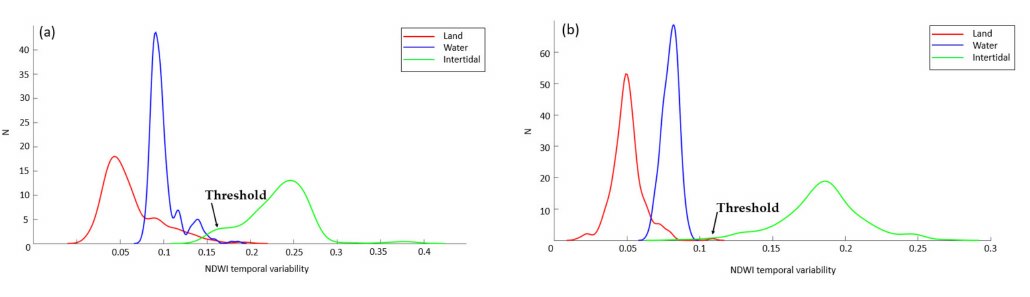
Figure 8. NDWI temporal variability of the three classes: water (blue), intertidal (green), and land (red); ( a ) Tagus estuary and ( b ) Bijag ó s